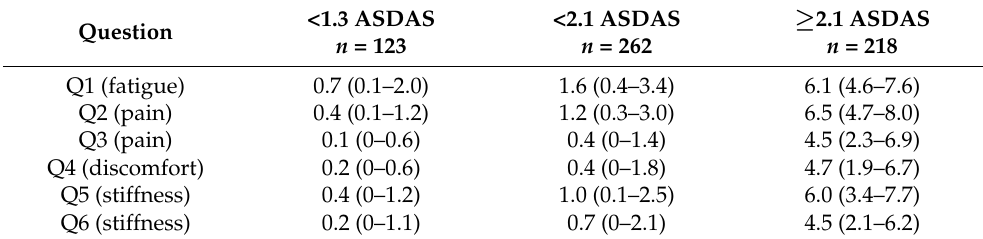
Table 2. Patient responses to specific questions related to BASDAI by ASDAS.